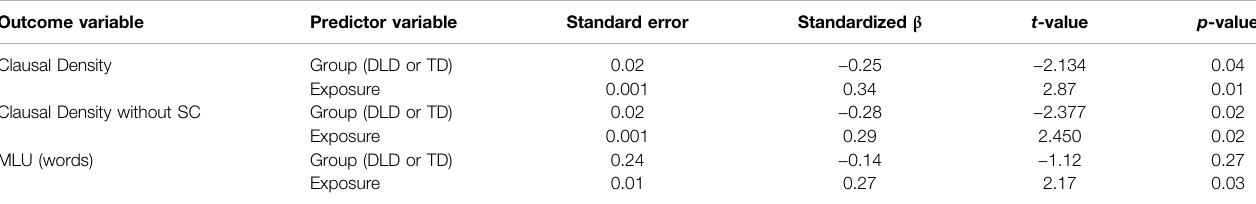
TABLE 6 | Linear regression results testing whether group membership is related to clausal density and